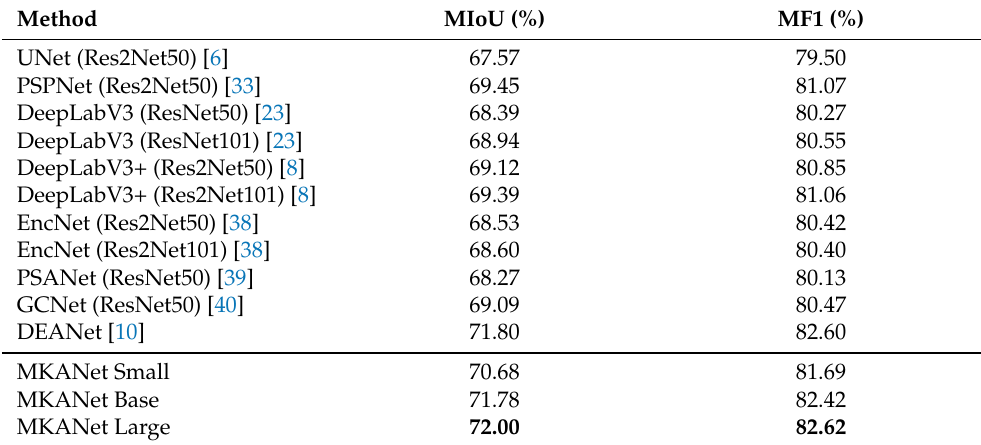
Table 5. Comparison of MKANets with large networks on the DeepGlobe Land Cover dataset.